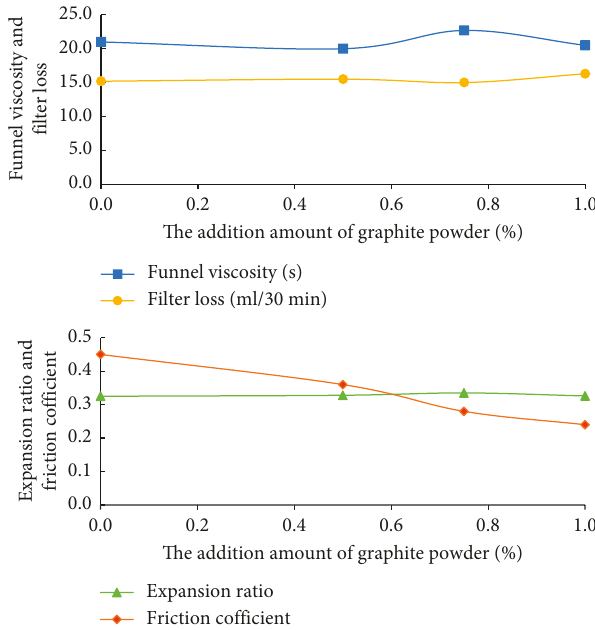
Figure 3: The effect of potassium humate on the slurry properties.